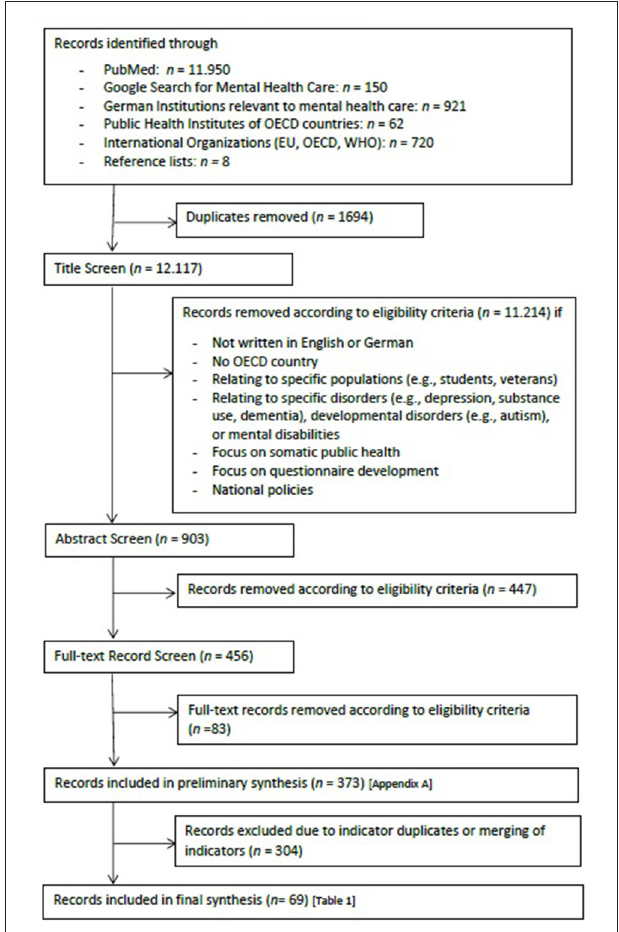
FIGURE 1 | Flow chart scoping